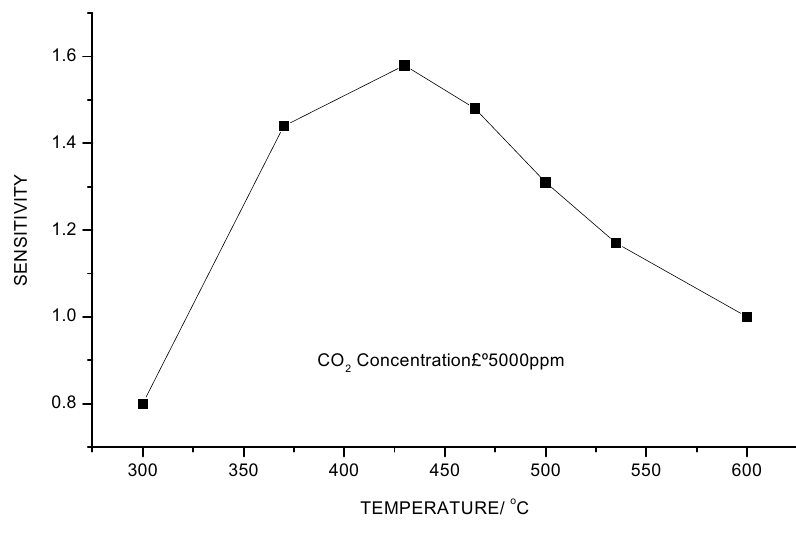
Figure 2. The temperature-sensitivity curve of Ag – doped CuO-BaTiO